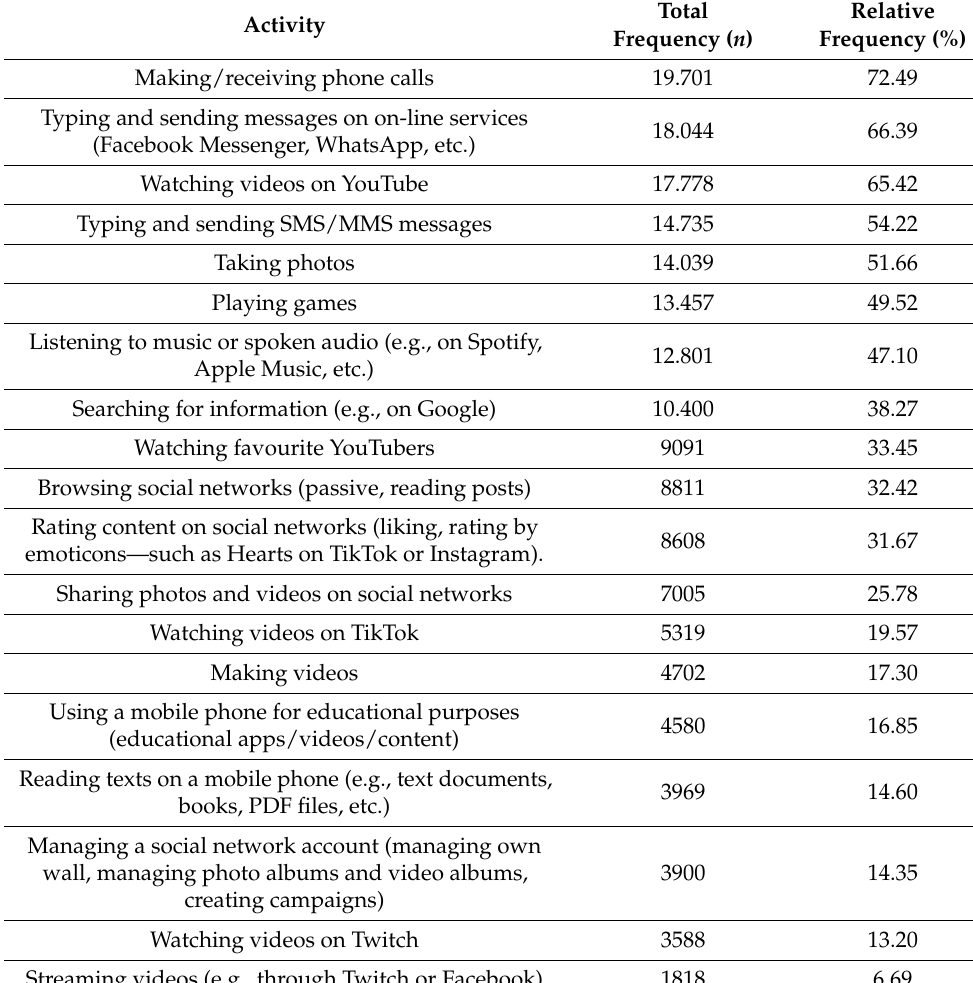
Table 1. Most frequent activities on a mobile phone.